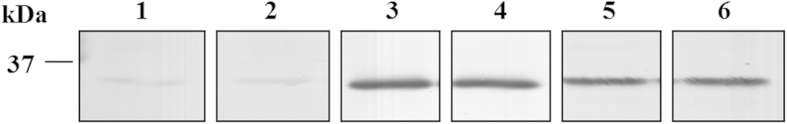
Immunoblot with anti-Pv2.5–8 antibody on P. vittata roots (lanes 1–2), fronds (lanes 3–4) treated or not once a week with 334 μM and gametophytes treated or not with 8 mM As (lanes 5–6).Controls: lanes 1, 3, 5; arsenic treatment: lanes 2, 4, 6.